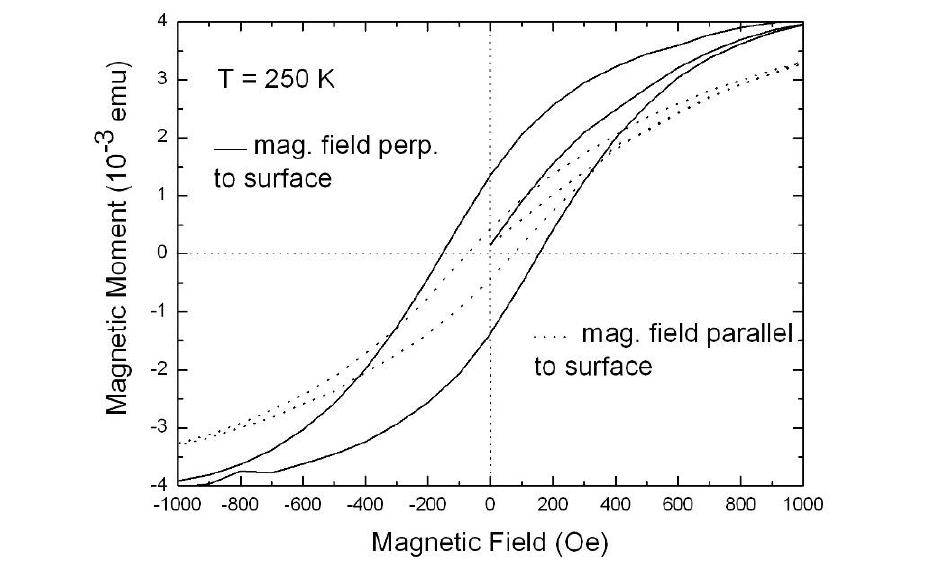
Figure 26. Hystereses loops of a PS-matrix filled with a large amount of Ni-wires (length of a few microns). The anisotropy between easy axis (magnetic field perpendicular to the surface) and hard axis magnetization (magnetic field parallel to the surface) is mainly caused by the shape of the deposited structures (diameter ~60 nm, aspect ratio ~80)